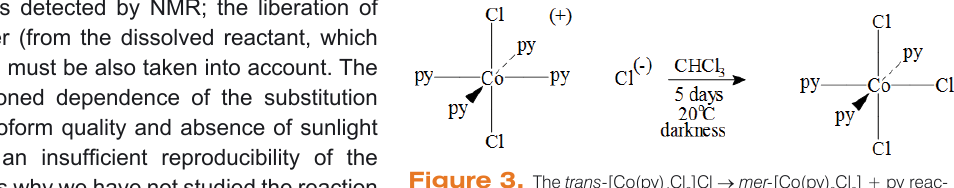
Cl ]Cl → mer- [Co(py) 4 2